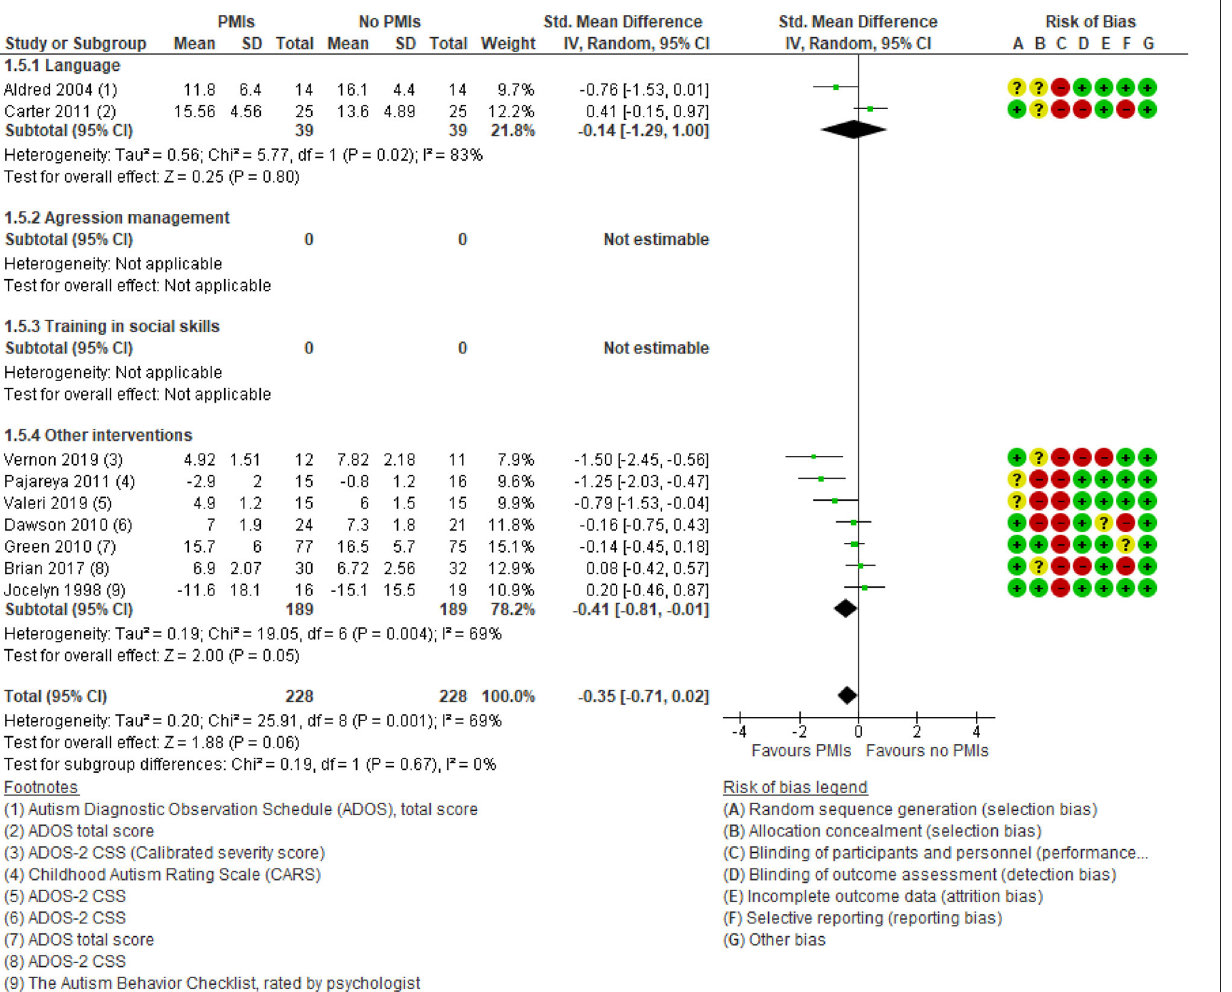
FIGURE 8 | Forest plot of comparison: PMI vs. no PMI, outcome: autism core symptoms, clinician-rated.